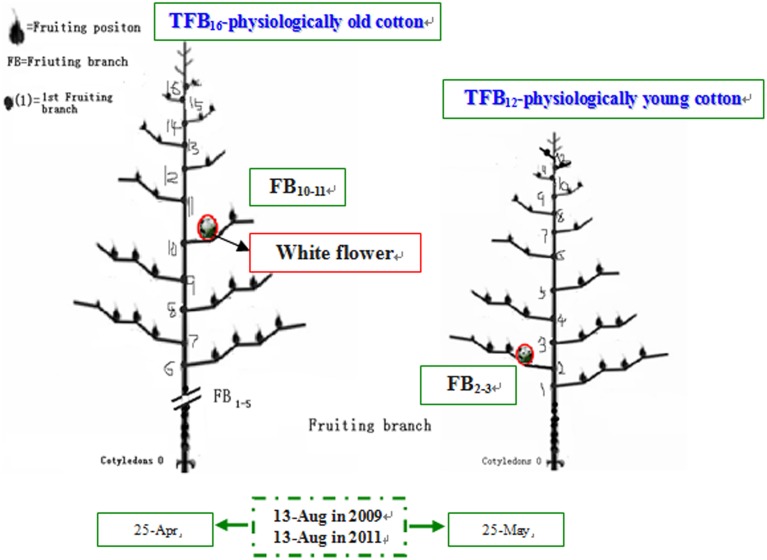
Schematic diagram of cotton physiological age in 2009 and 2011 adapted from Liu et al. (2014).